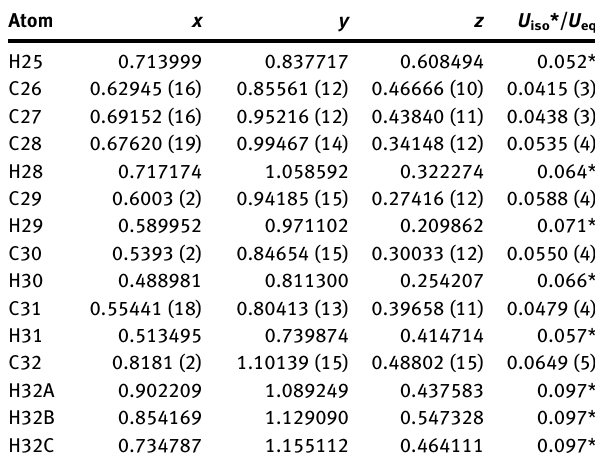
Table  : Fractional atomic coordinates and isotropic or equivalent isotropic displacement parameters (Å 